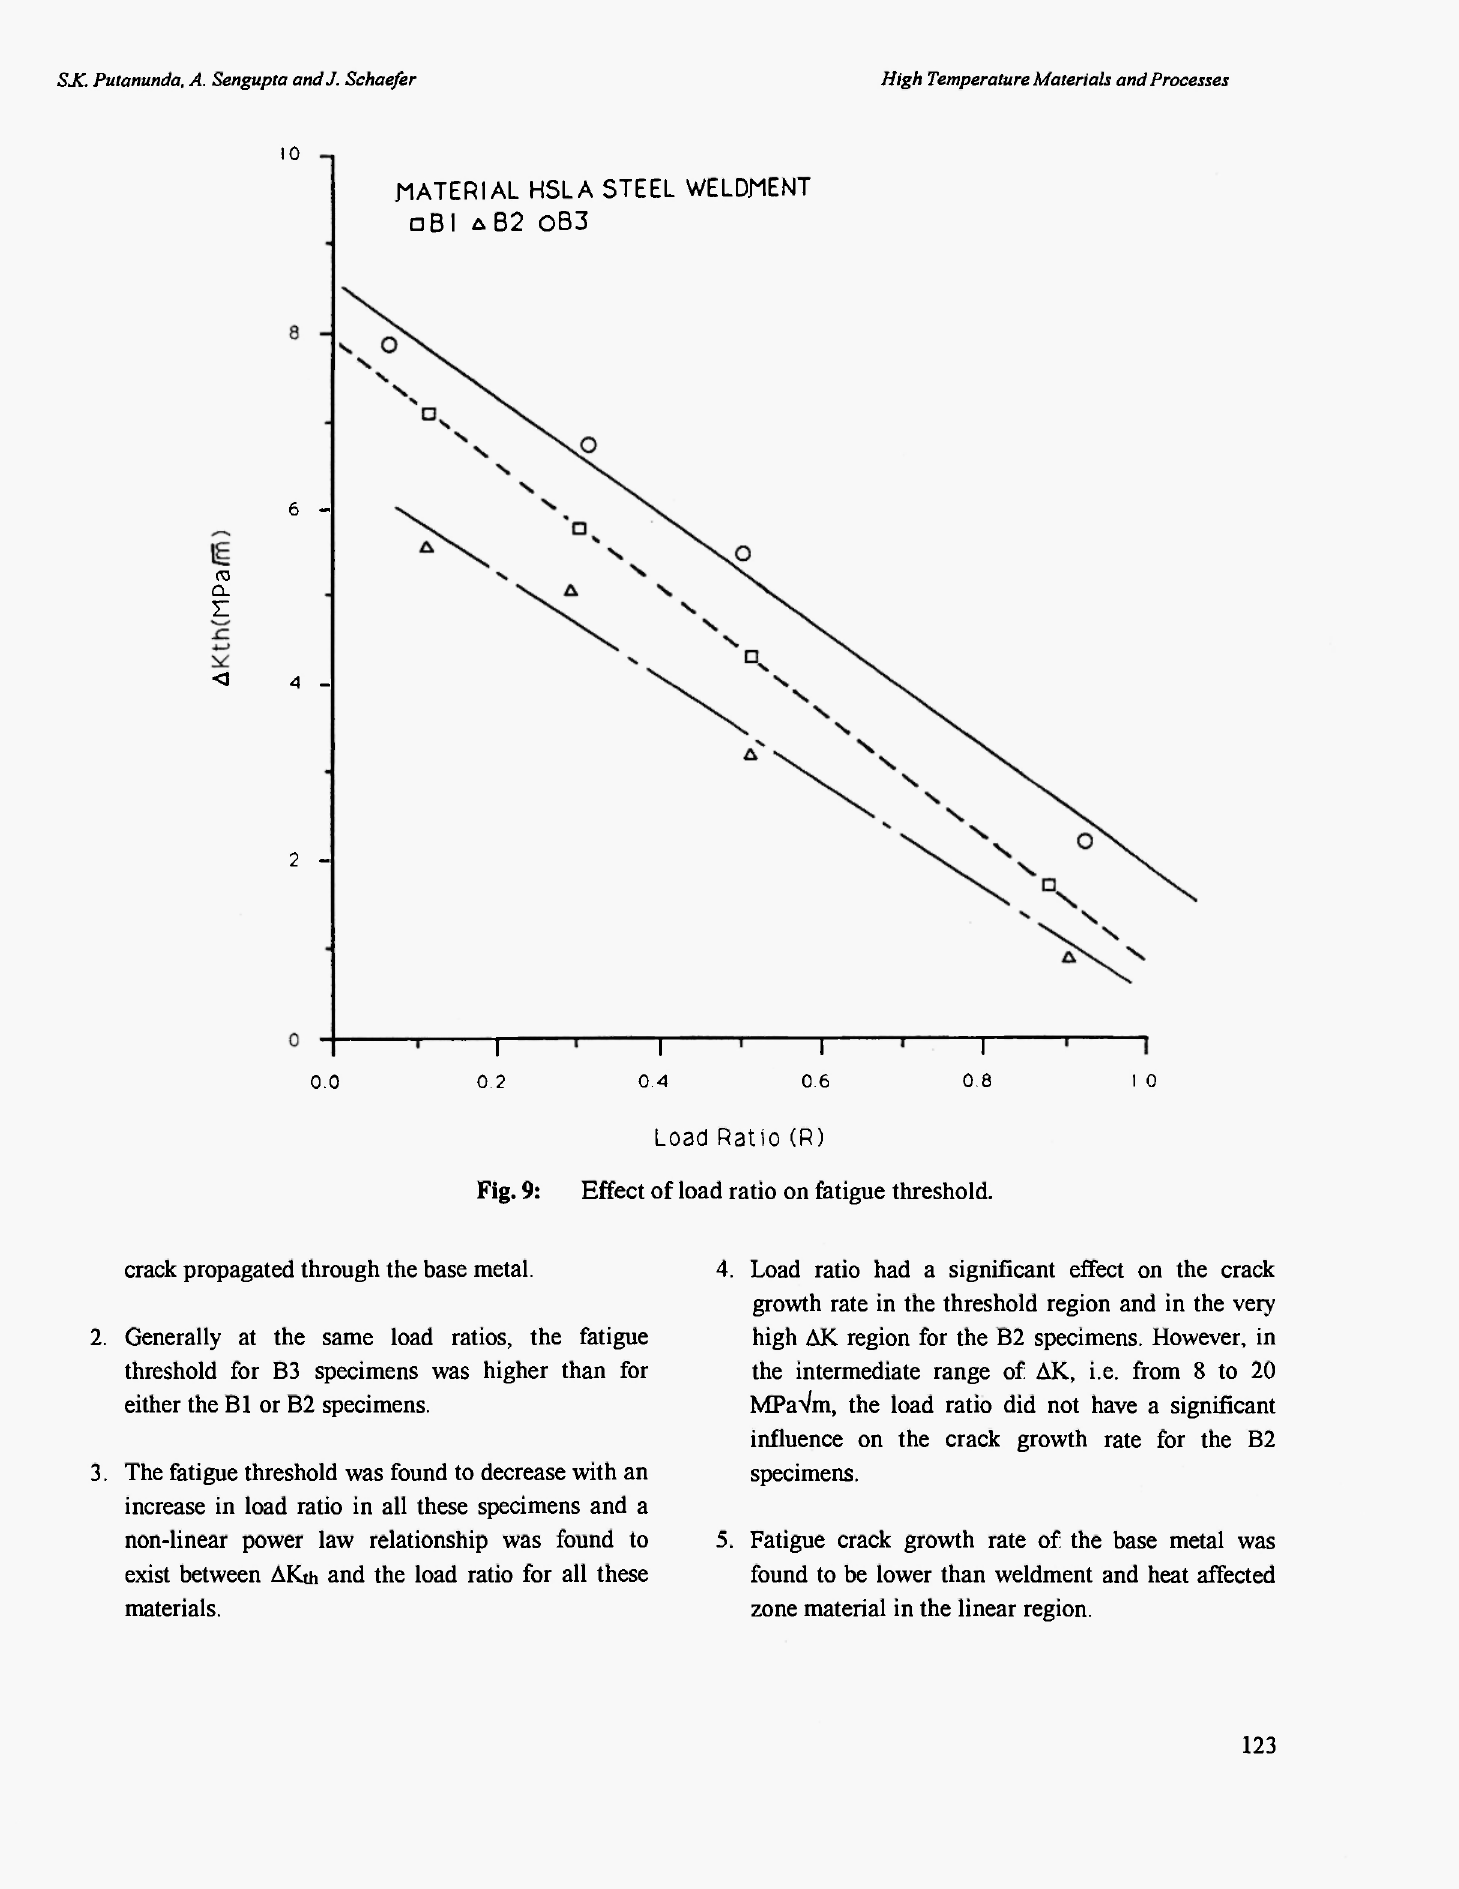
Γ 0.4 Load Ratio (R) Effect of load ratio on fatigue Fig. 9: